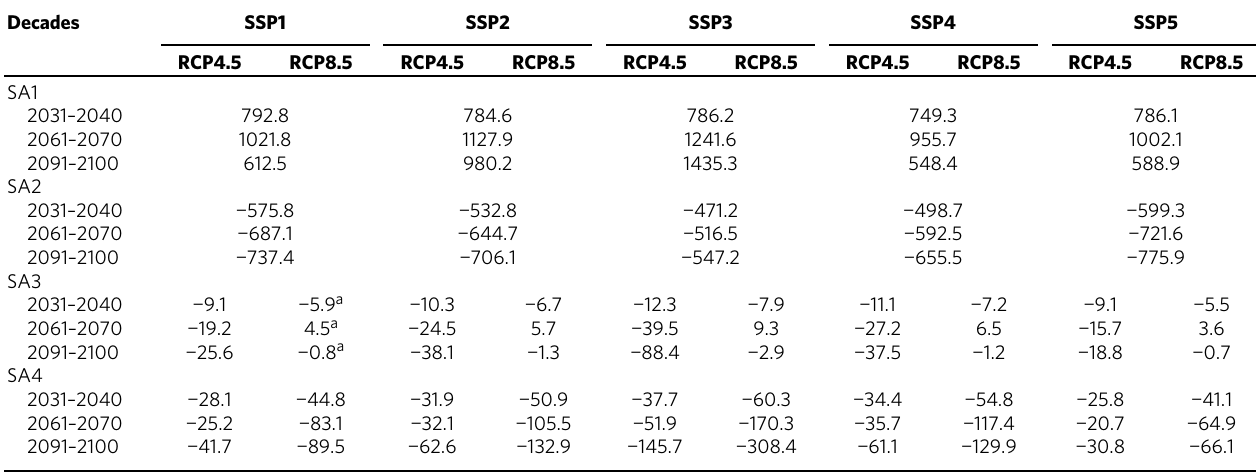
Table 3 Changes in projected premature mortality burden for the four sensitivity studies (SA) relative to the burden in the baseline period. Values are in 1000s. The details of the four sensitivity studies are summarized in Table 2